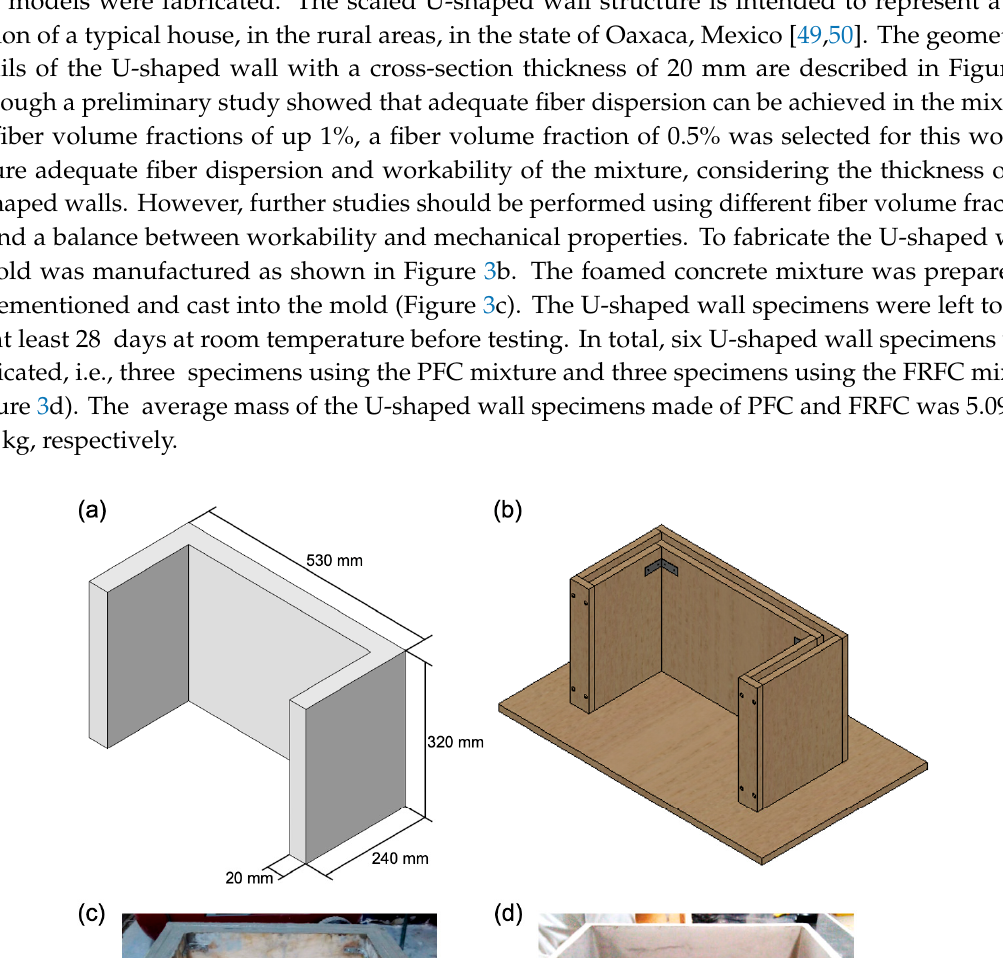
Table 1. Mechanical properties of PFC and FRFC.